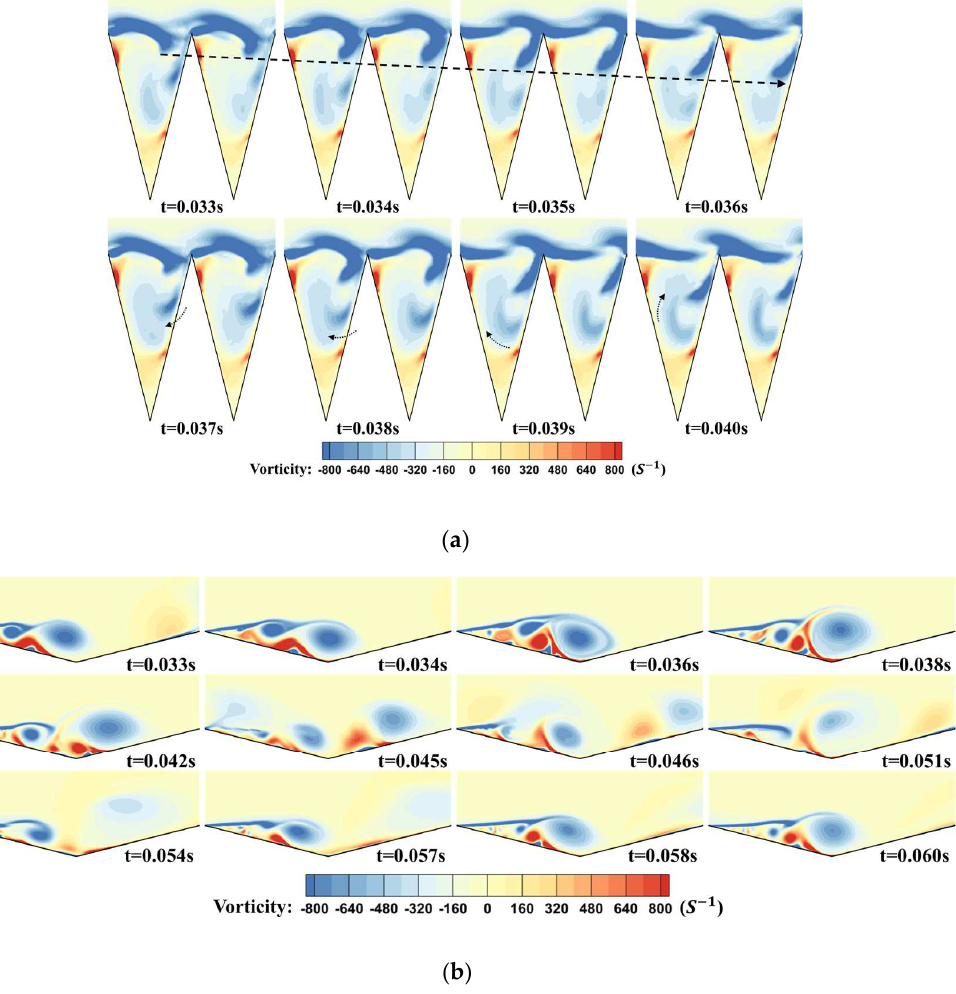
Figure 17. The 3D isometric of the instantaneous coherent structures with indicator λ ci . ( a ) Identi- fication of the random perturbation vortices in the computational domain with λ ci > 80, and ( b ) identification of boundary vortices inside the groove with λ ci > 540. Figures 18–20 show the evolution of the instantaneous spanwise vorticity in the grooves with different ARs at Re = 5.44E4, where the ARs = 0.5 and 8 (Figure 18) at region III, the ARs = 1 and 5 (Figure 19) belonging to region II, and the AR = 2 (Figure 20) at region I were predicted theoretically as shown in Figure 12.